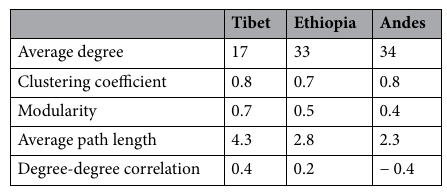
Table 2. Global properties of co-mutation networks.